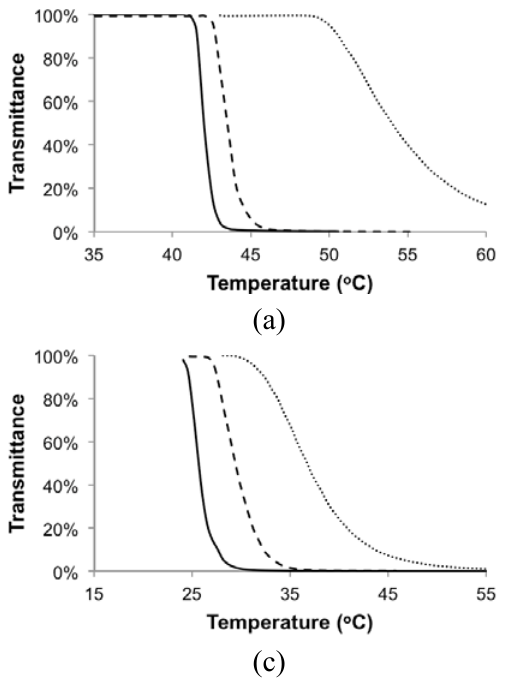
Figure 4. Light transmittance as a function of temperature of poly(DMAEMA- stat -styrene) copolymers with (a) F = 96 mol% (DMAEMA/S-95/5) (b) F DMAEMA = 84 mol% (DMAEMA/S-85/15) (d) F (DMAEMA/S-90/10) (c) F DMAEMA (DMAEMA/S-80/20) at 0.1 wt% (dotted line), 0.3 wt% (dashed line) and 0.5 wt% (solid line) in de-ionized water measured by UV-Vis